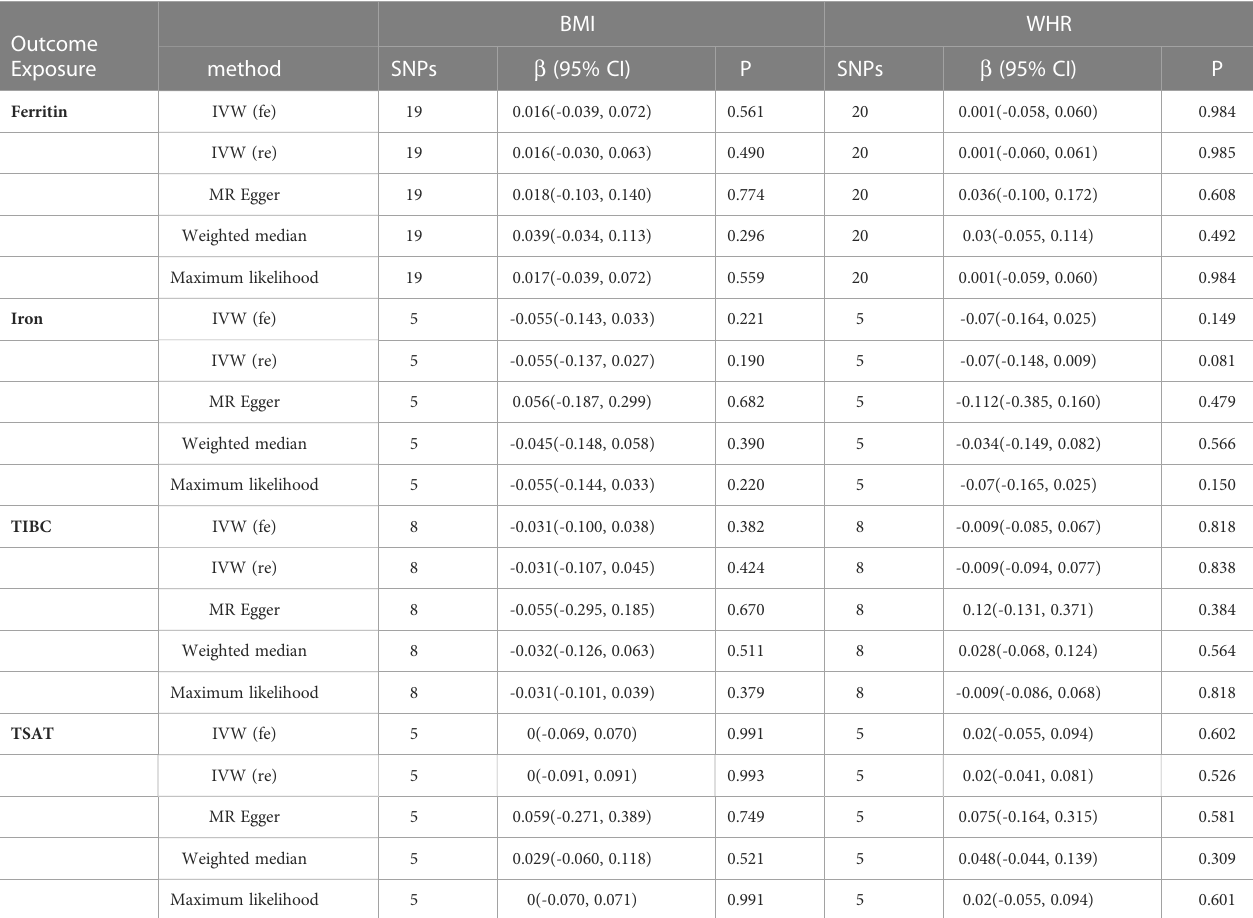
TABLE 1 MR results of the causal estimates of genetically predicted iron status on obesity-related